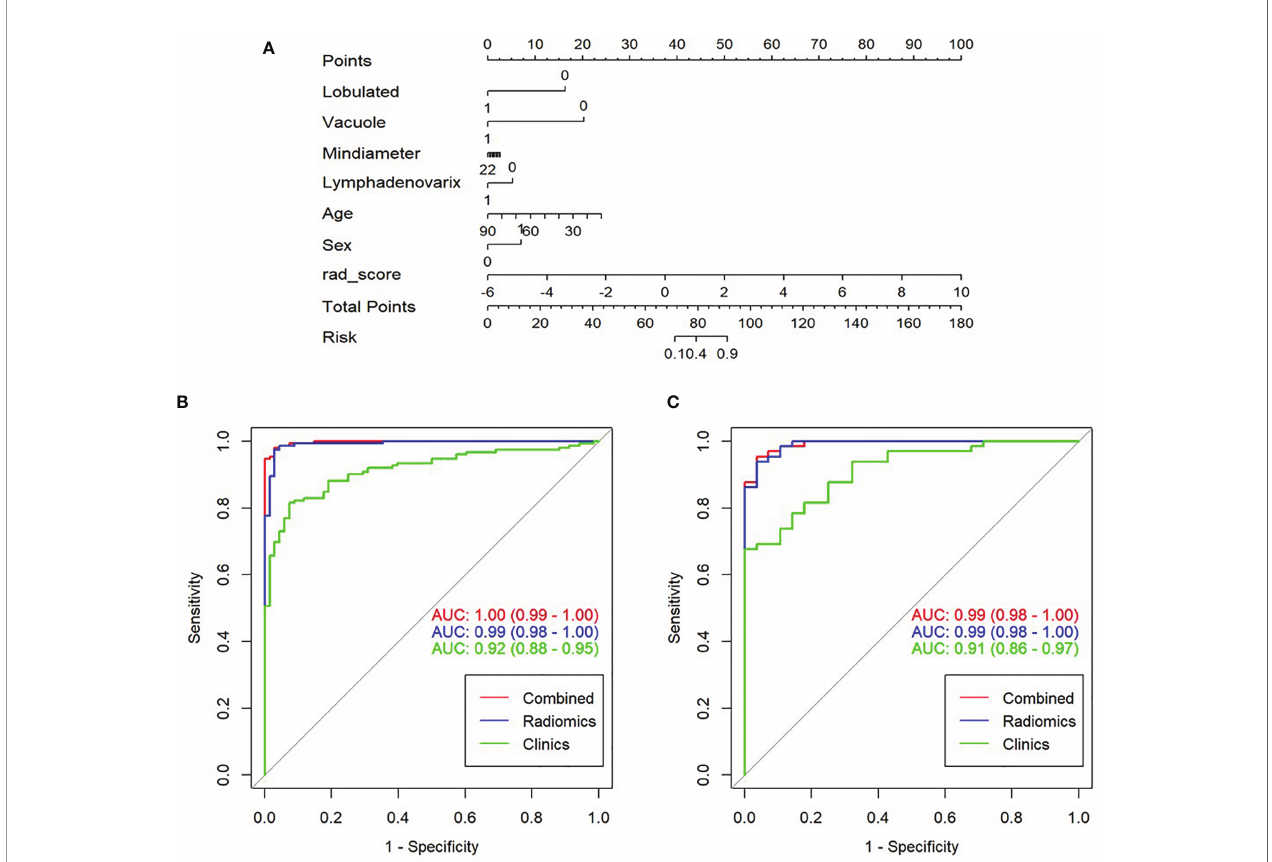
FIGURE 4 | Construction, performance, and validation of radiomics nomogram. (A) The radiomics nomogram was developed using seven selected radiomics parameters and two clinical features. Receiver operating characteristic (ROC) curves of nomogram and clinical model in training set (B) and validation set (C)